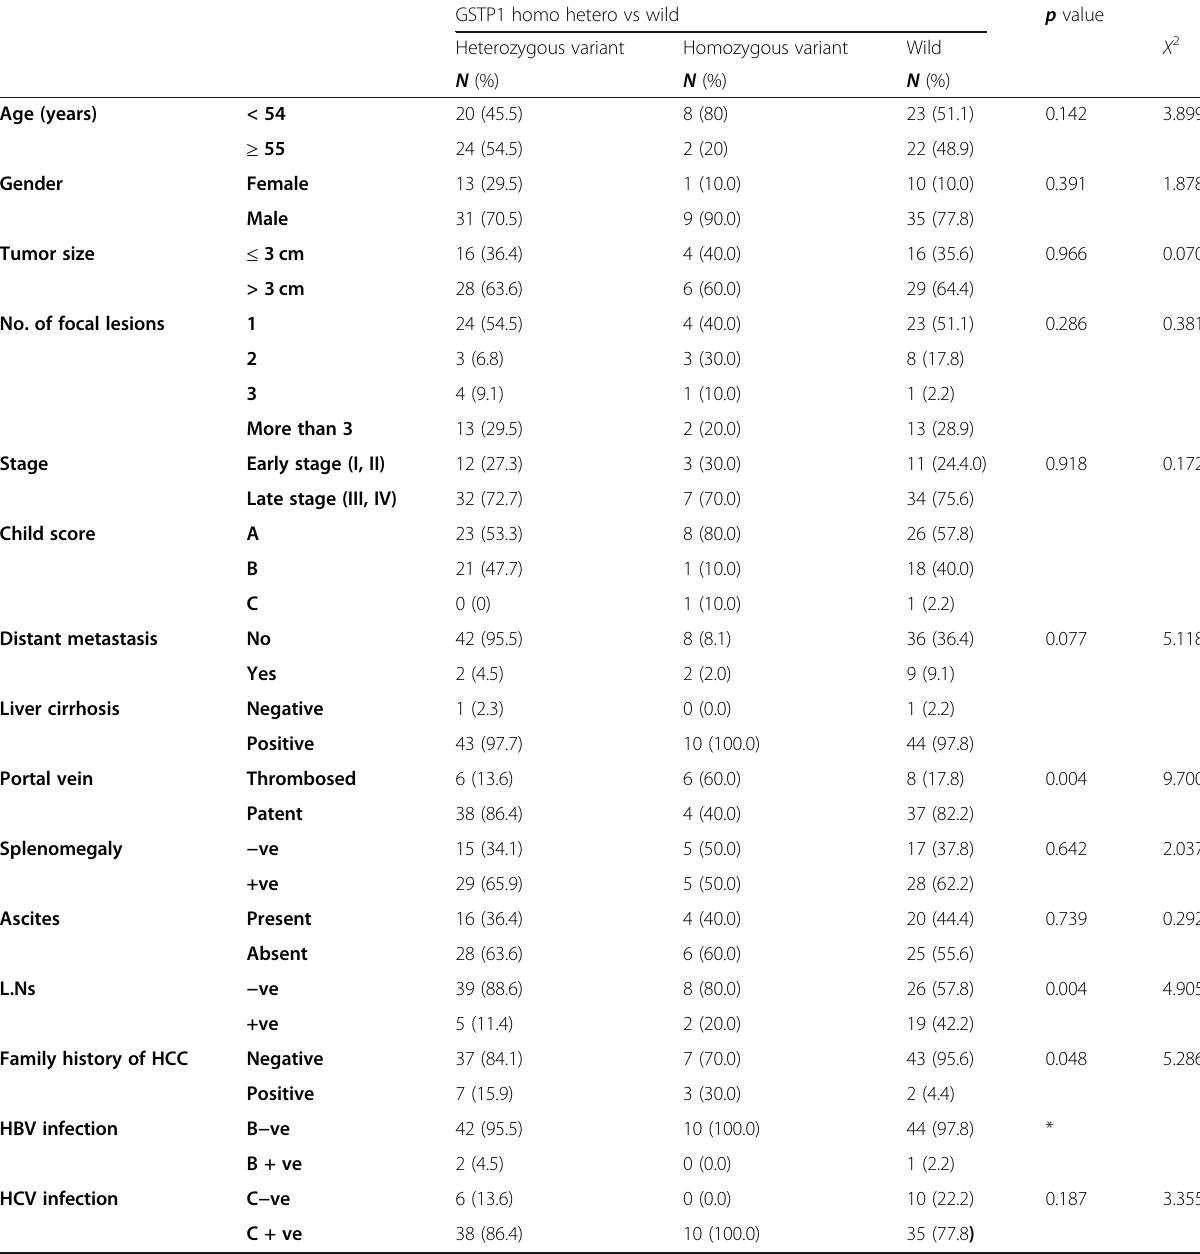
Table 5 Association of the different genotypes of glutathione S-transferase P1 with some prognostic factors of HCC using chi-square